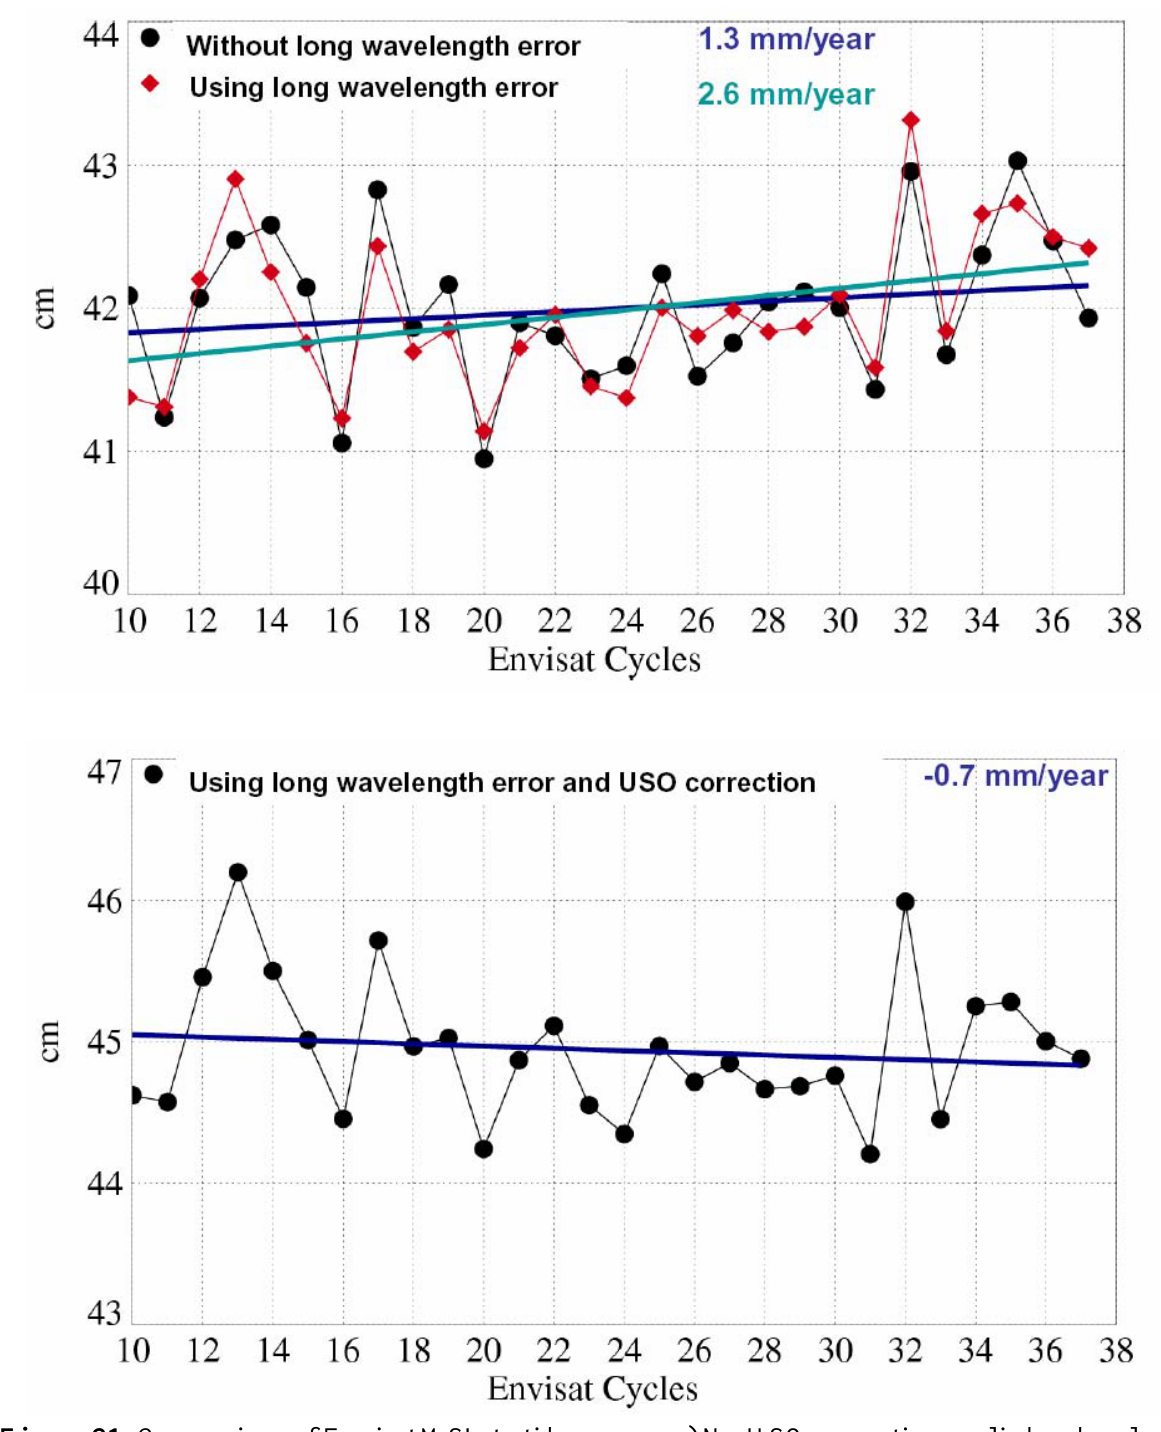
Figure 21. Comparison of Envisat MSL to tide gauges. a) No USO correction applied and no long wave length error applied (dots), No USO correction applied and but a long wave length applied (diamonds); b) USO correction applied and a long wave length